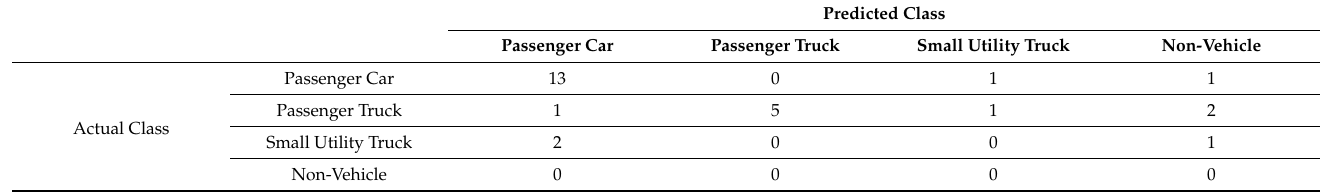
Table 12. Multiple vehicle cluster detections confusion matrix for Video